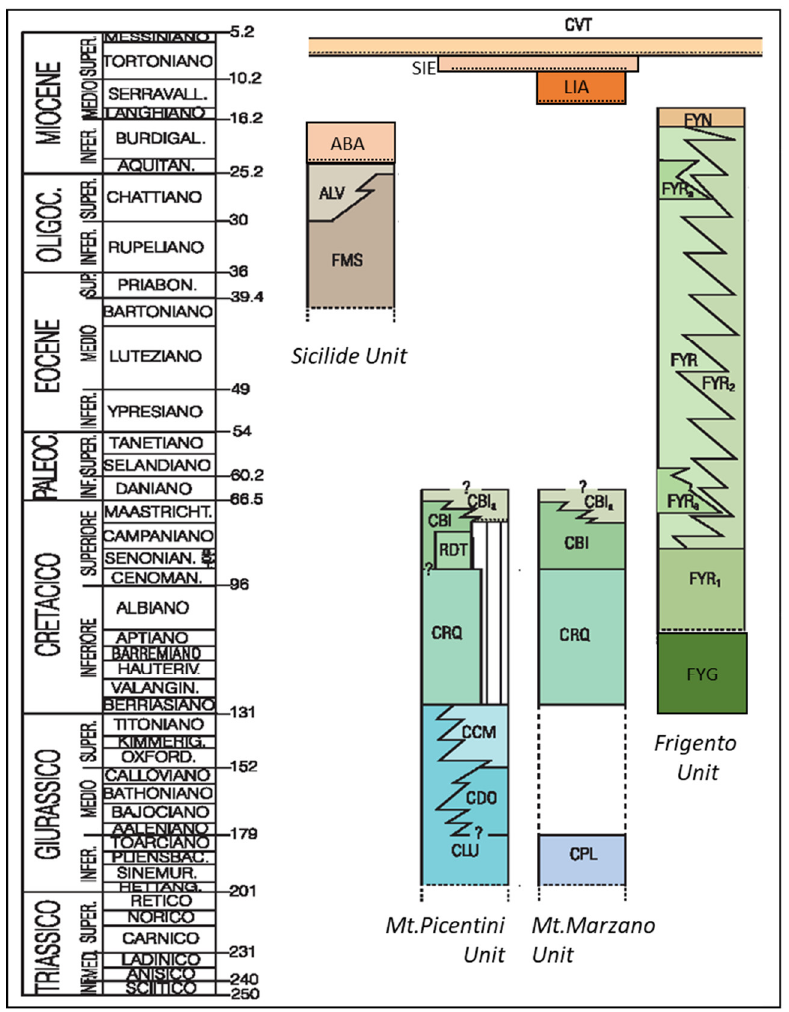
Figure 3. Chronostratigraphic scheme of the geological units cropping out in the study area (modified after [82]). Legend: Monte S. Arcangelo Fm. ( FMS ), Argille Varicolori Superiori Fm. ( ALV ), Albanella/Corleto unit ( ABA ), Palaeodasycladus limestone fm. ( CPL ), limestone and dolomitic limestone fm. ( CLU ), oolitic ed oncolitic limestone fm. ( CDO ), Cladocoropsis and Clypeina limestone fm. ( CCM ), requienia and gasteropods limestone fm. ( CRQ ), Radiolitidae Limestone fm. ( RDT ), bio-litoclastic rudist limestone fm. ( CBI ), “Pseudosaccharoidal” limestone lithofacies ( CBIa ), Flysch Galestrino Fm. ( FYG ), Flysch Rosso Fm. ( FYR ), limestone member ( FYR2 ) or lithofacies ( FYRa ), Numidian Flysch ( FYN ), Laviano calcarenites fm. ( LIA ), Monte Sierio Fm. ( SIE ), Castelvetere Formation ( CVT ).